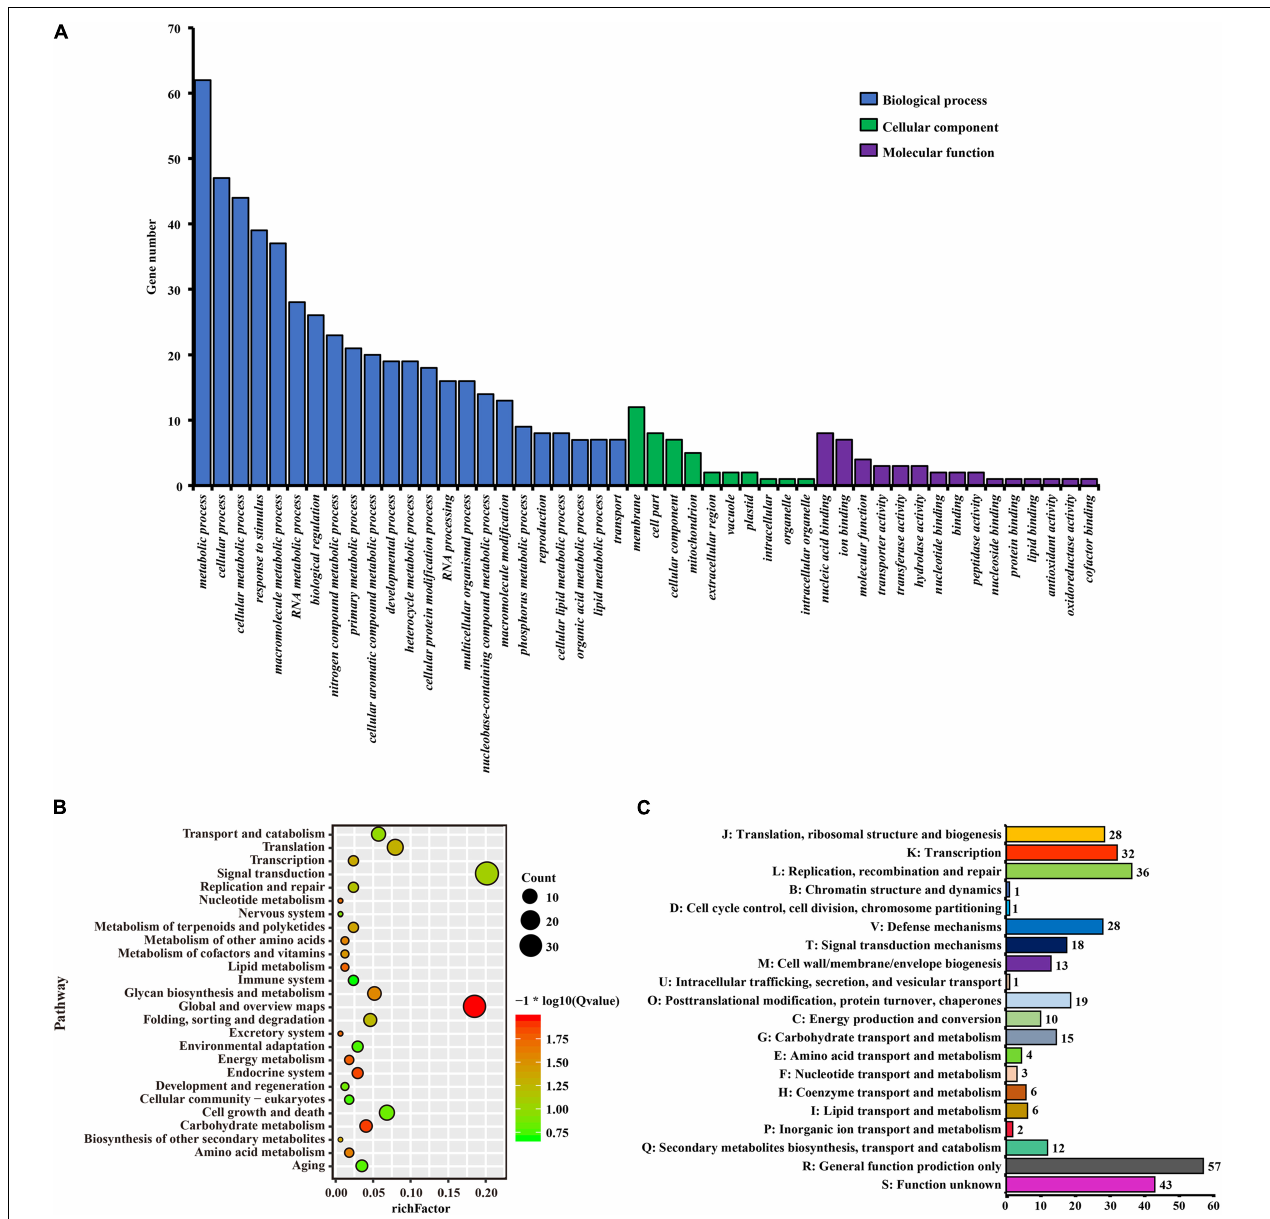
FIGURE 7 | The function enrichment analyses of PSGs in Urophysa species. (A) GO annotation results; (B) KEGG annotation results; (C) COG annotation